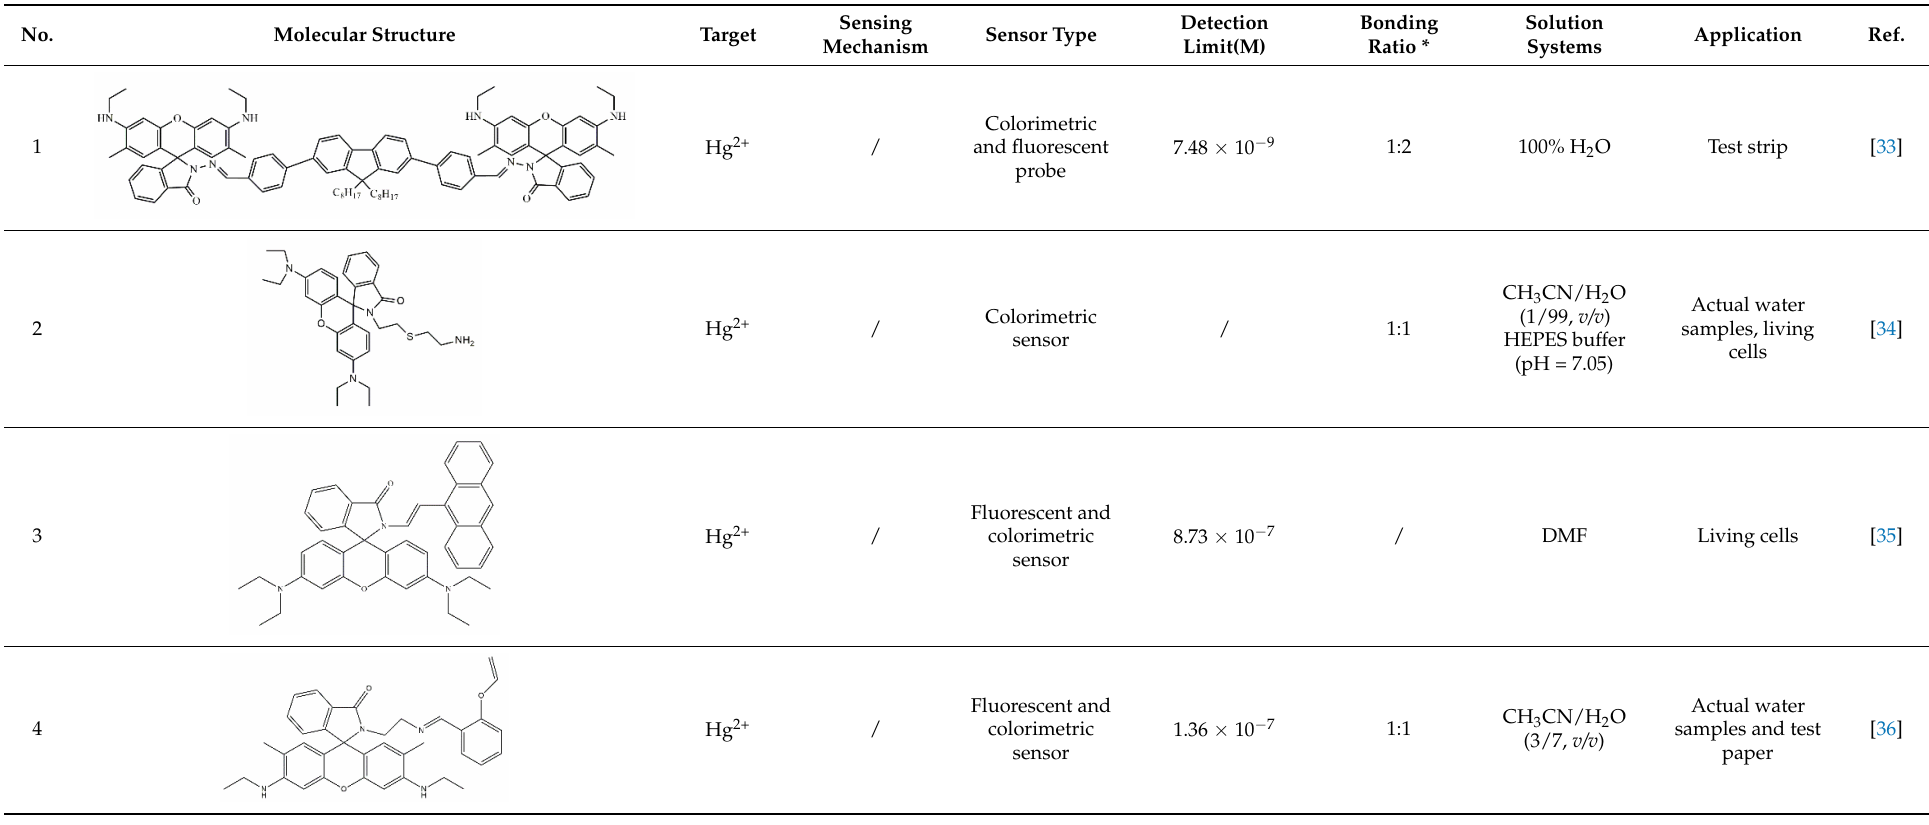
Table 1. Rhodamine-based sensors for metal